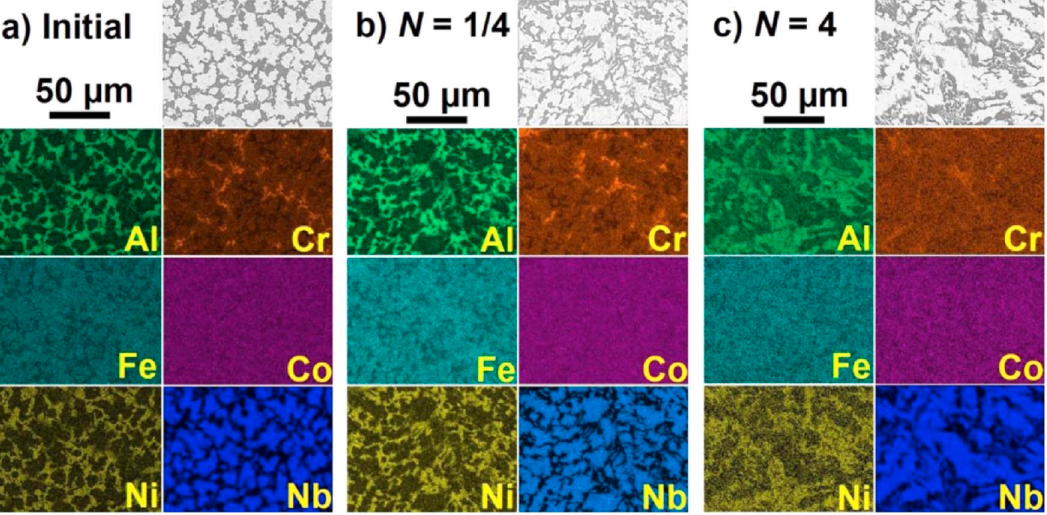
Figure 8. Scanning electron microscopy (SEM) micrographs ( top ) and corresponding electron dis- persive X-ray (EDX) elemental mappings for ( a ) initial AlCrFeCoNiNb high-entropy alloy and for samples processed by HPT for ( b ) 1/4 and ( c ) 4 turns. Reprinted with permission from Ref. [122]. Copyright 2021 Elsevier.